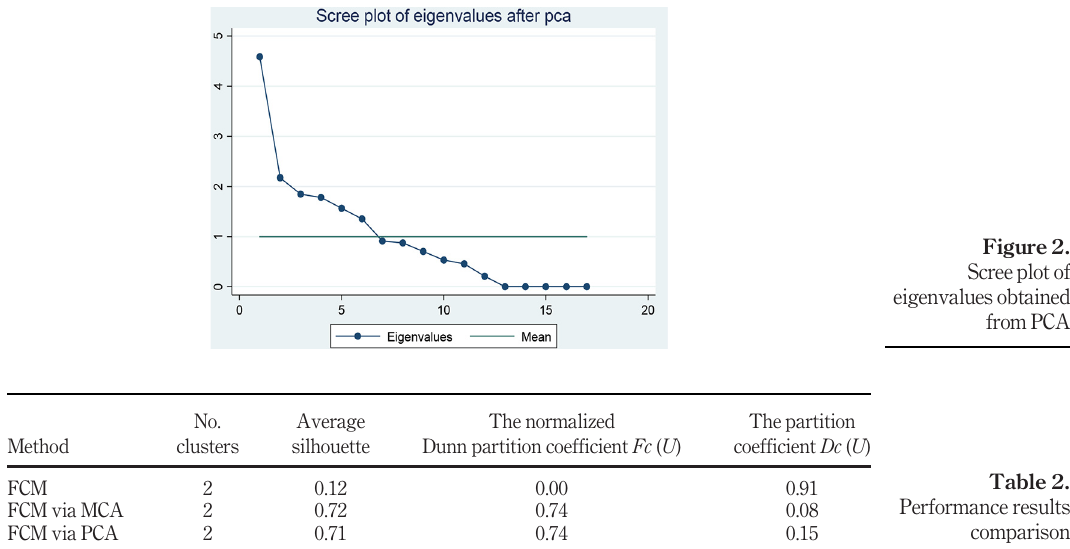
Figure 2. Scree plot of eigenvalues obtained from